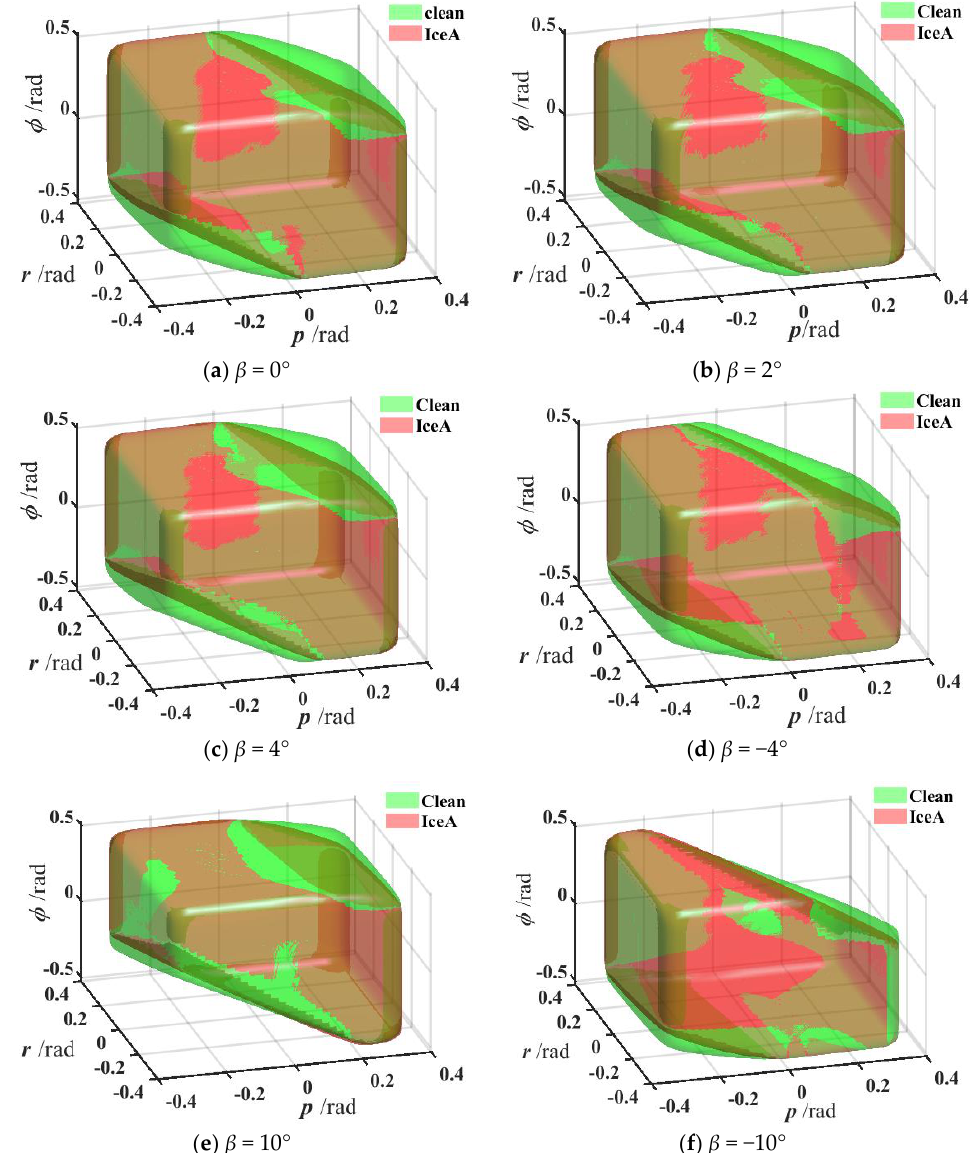
Figure 6. Flight safety envelope curve for clean configuration/heavy-icing configuration with different sideslip angles.